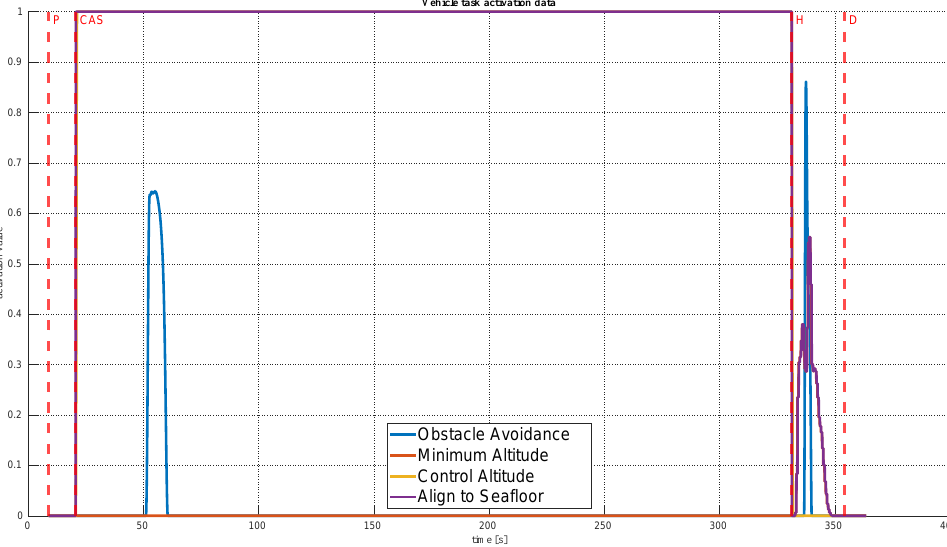
Figure 18. Constant altitude mission: Time behavior of Obstacle Avoidance, Minimum Altitude, Vehicle Altitude and Seafloor Alignment task activation functions. The various phases of the mission are denoted in the plot as follows: P—Parking, CAS—Constant Altitude Survey, H—Homing,